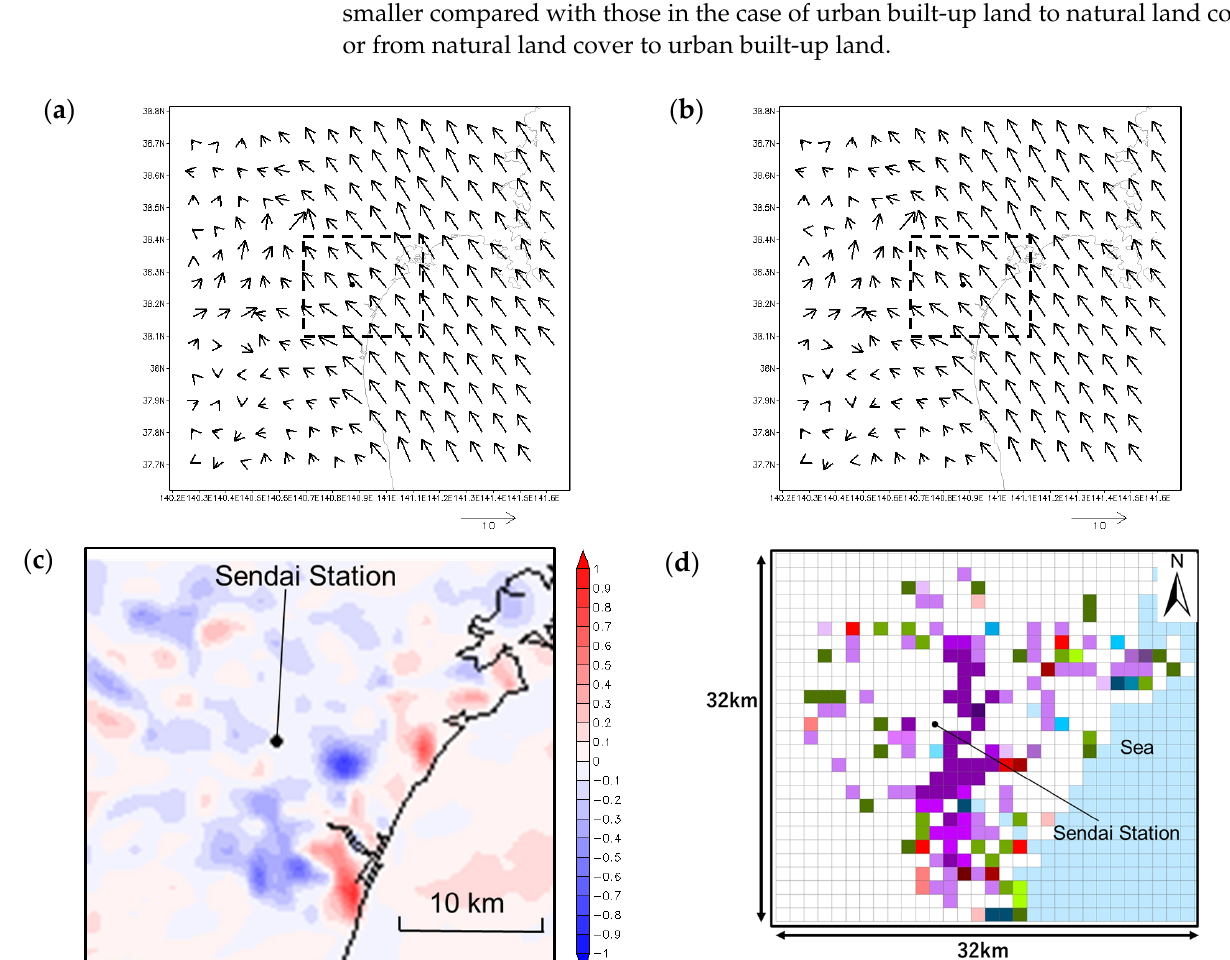
Figure 7. Daytime wind {m/s} fields. ( a ) In Case lu_2002; ( b ) in Case lu_2022; ( c ) scalar difference of wind speed (between Case lu_2022 and Case lu_2002); and ( d ) land use changes between 2002 and 2022 in Sendai (reposted Figure